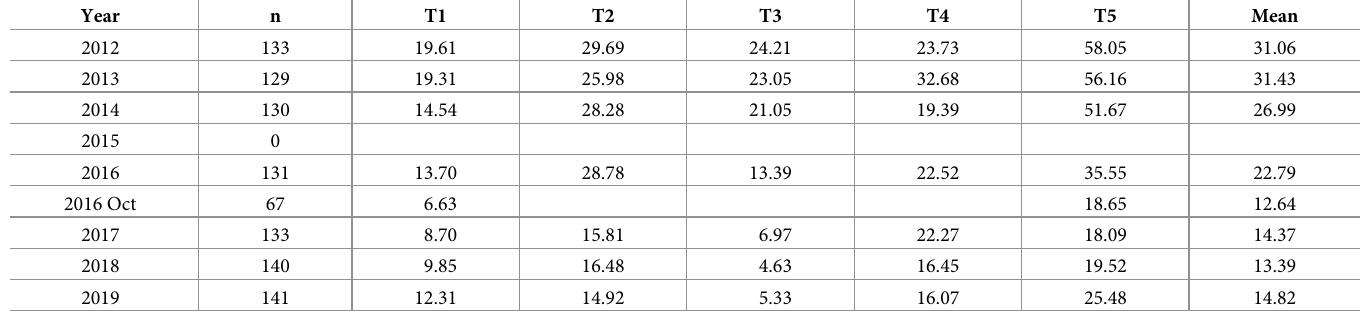
Table 1. Number of 1 m 2 quadrats and percent mean live coral abundance per year from 2012–2019 at Coral Gardens. Transect locations are indicated with T1-T5, and n is the number of 1 m 2 photographed quadrats. The mean is the percentage mean of five equally weighted